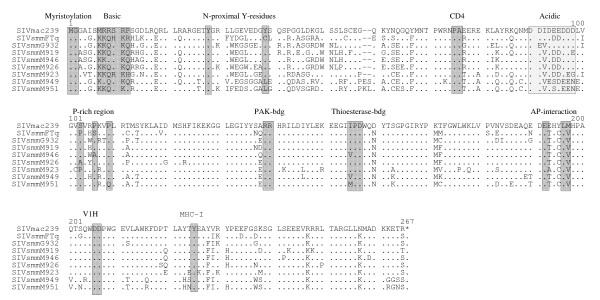
Alignment of SIV and HIV-2 Nef sequences. The SIVmac239 sequence is shown in the upper panel for comparison. Some conserved sequence elements in Nef, including the N-terminal myristoylation signal, N-proximal tyrosines (52–54), PA residues known to be critical for CD4 down-modulation by 239 wt Nef (58), the acidic and proline-rich regions, a diarginine motif, a C-proximal adaptor-protein (AP) interaction site (52), a diacidic putative VlH binding site and a Y residue involved in MHC-I down-regulation (52, 56,57) are indicated schematically. Dots indicate identity with the 239 wt Nef sequence and dashes gaps introduced to optimize the alignment.